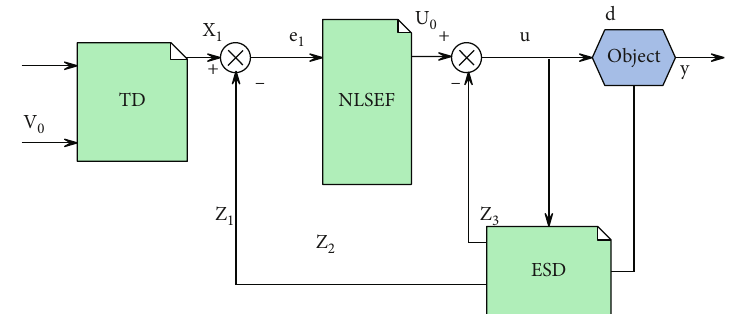
Figure 3: ADRC controller structure